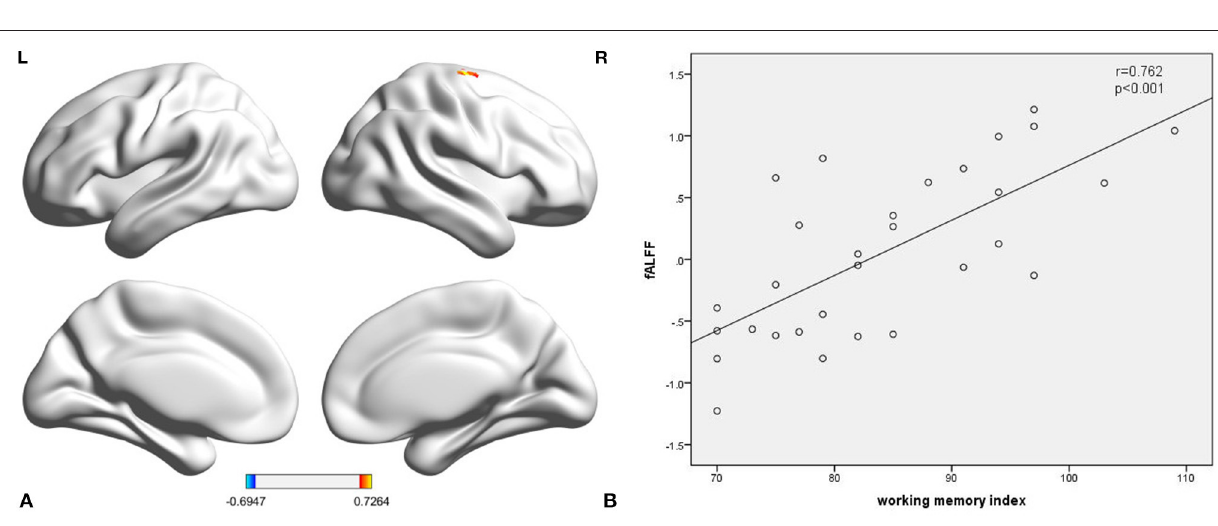
FIGURE 2 | The fALFF of the right precentral gyrus in TT homozygous was significantly correlated with working memory index ( r = 0.762, p < 0.001) (A,B) . fALFF, fractional amplitude low-frequency